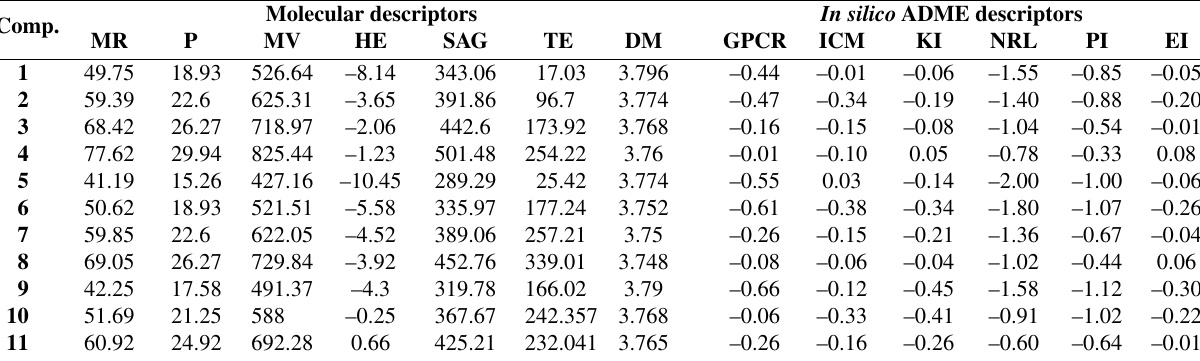
Table 2. The values of the molecular and in silico ADME descriptors. Molecular